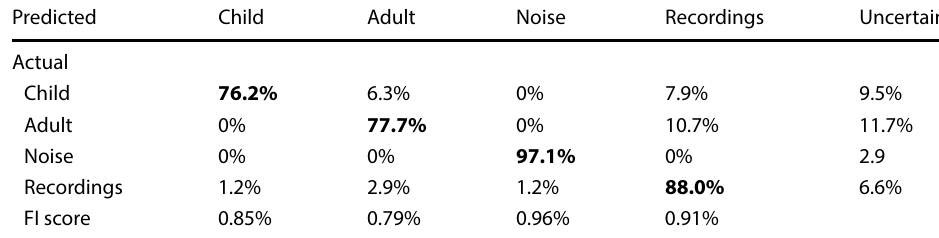
Table 5 Confusion matrix after adding synthetic voices